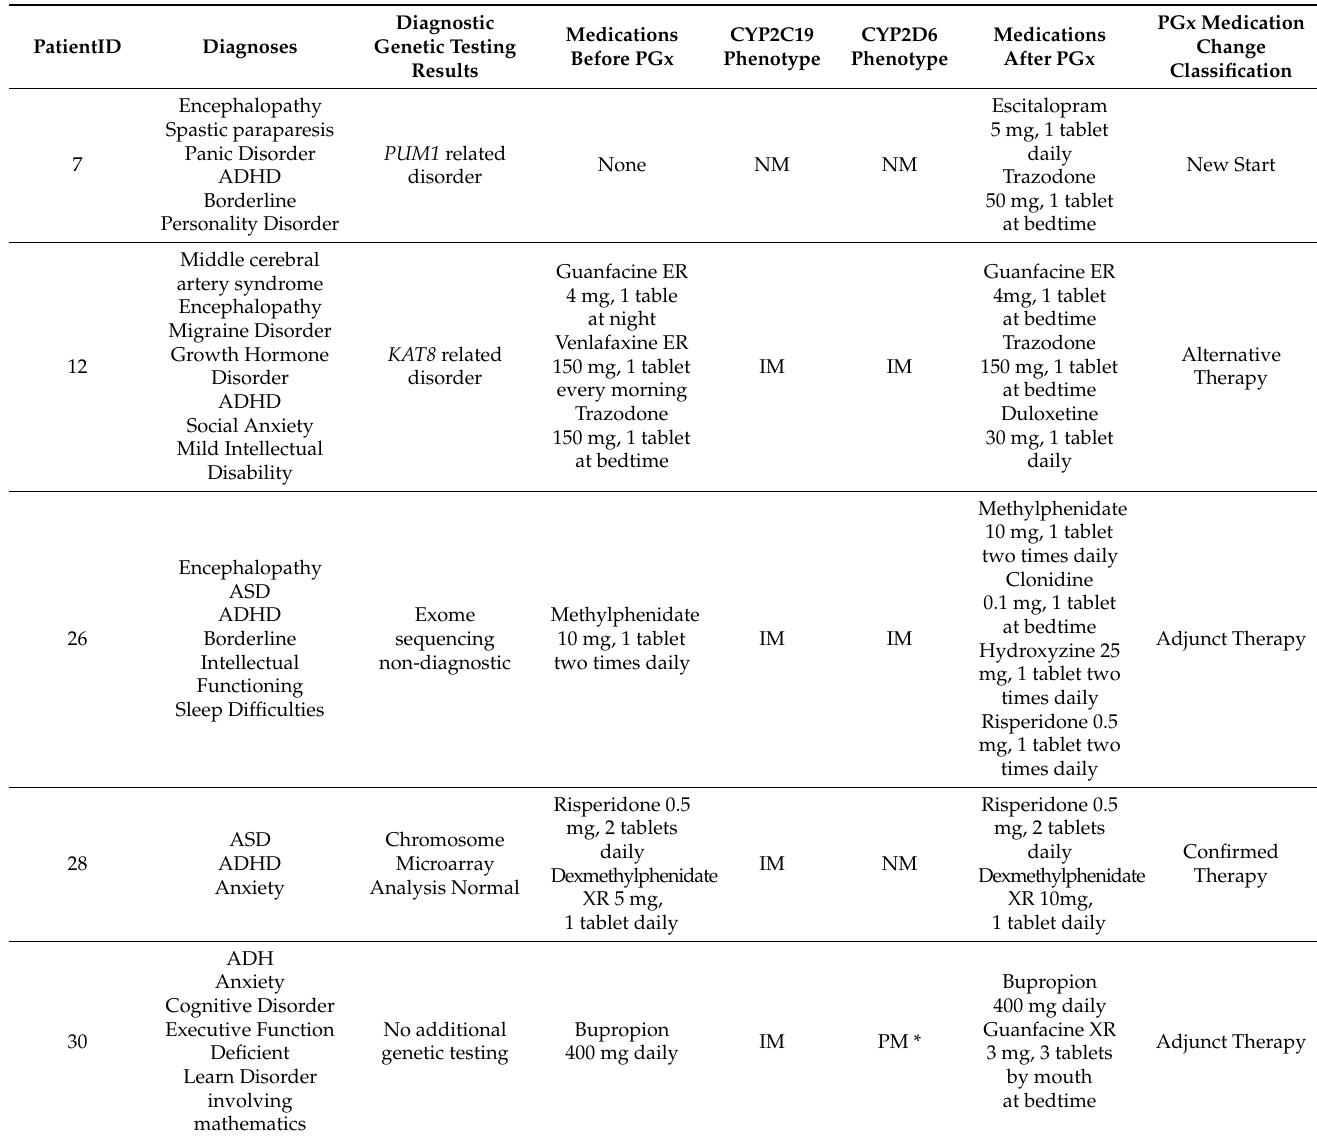
Table 6. Examples of PGx adoption by the NWA-PPCS multidisciplinary team for guidance of therapy in patients with NDD/NBD.